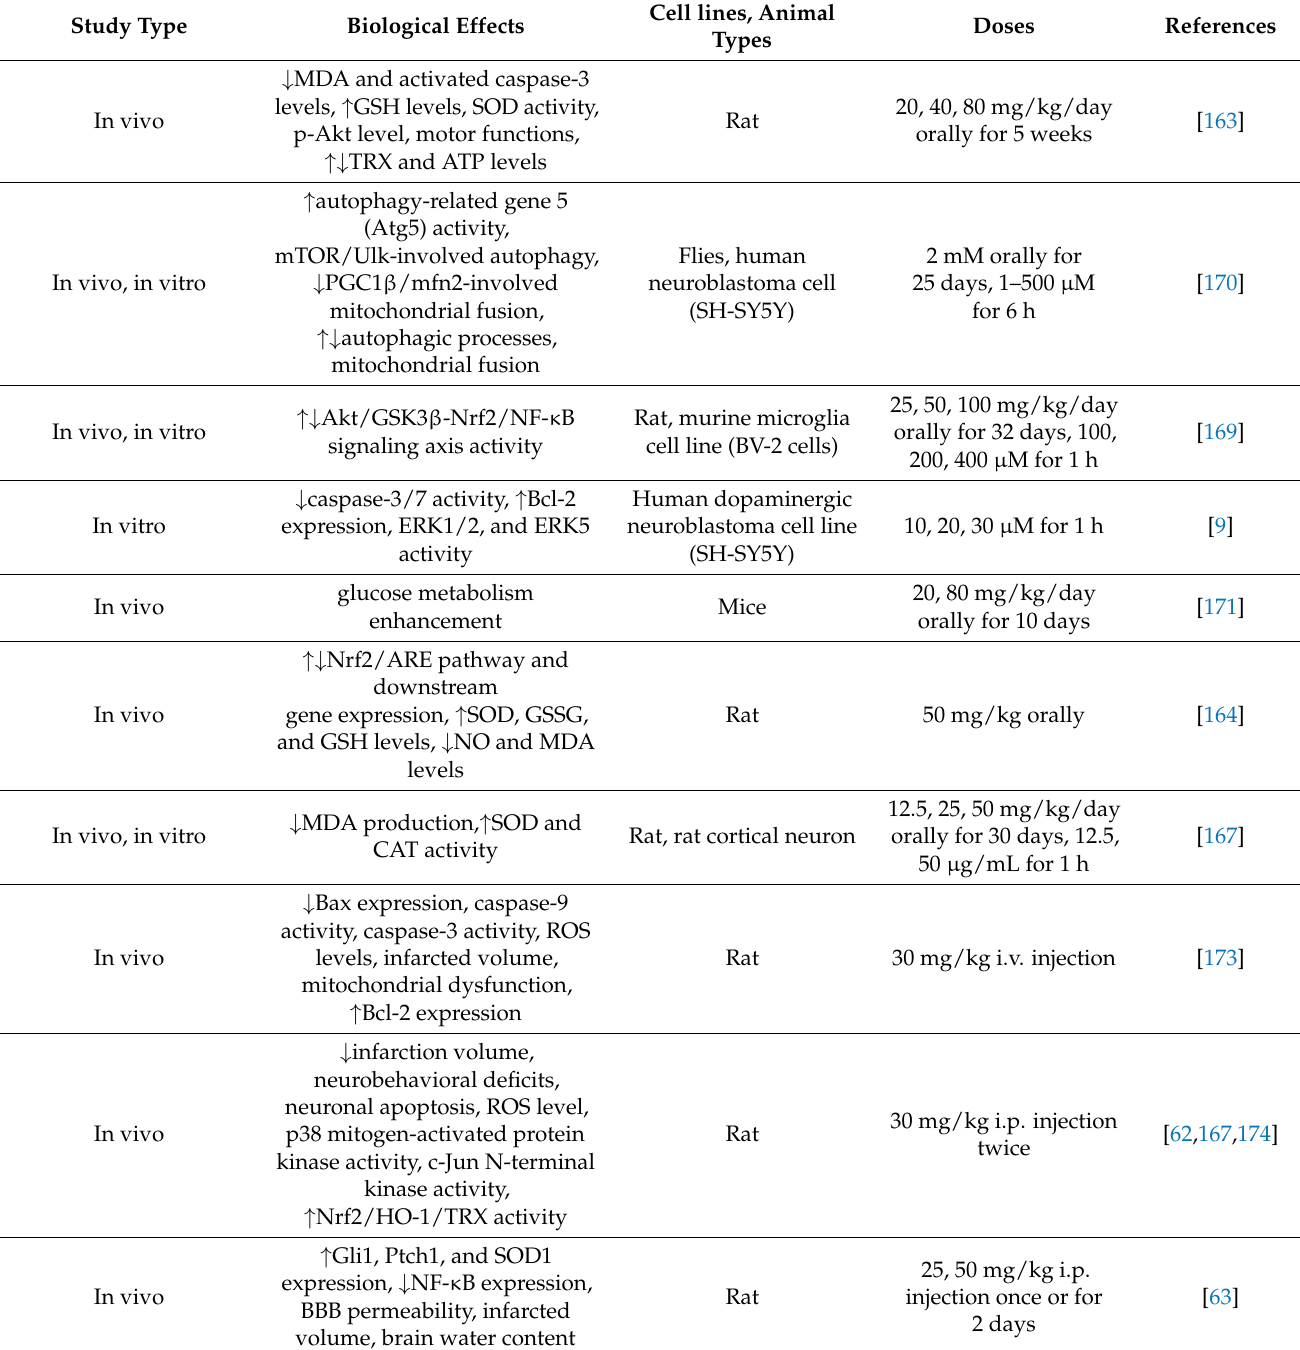
Table 4. Neuroprotective effects of